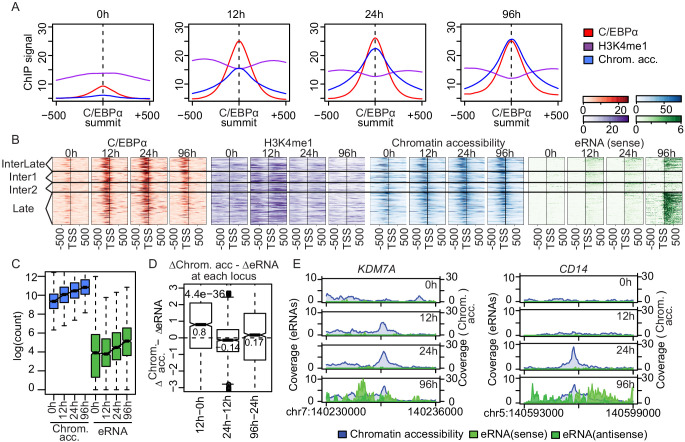
Enhancer transcription follows chromatin opening.(A) Average signal of ChIP-seq of C/EBPα (red) and H3K4me1 (purple) or ATAC-seq (blue) on C/EBPα binding sites where chromatin accessibility is limited at 0 hr (n = 4550). Each panel depicts coverage at the indicated time. (B) Coverage plots of genome-wide data sets as indicated. Rows of all panels represent enhancers occupied by C/EBPα, sorted by eRNA synthesis kinetics and intensity. The coverage was aligned to the transcription start site (TSS) of eRNAs. (C) Log2-transformed counts of chromatin accessibility and eRNA synthesis on enhancers within chromatin regions previously inaccessible at 0 hr. (D) Difference between changes of chromatin accessibility and changes in eRNA synthesis at each locus (y-axis) between indicated time points (x-axis). Log2-transformed counts of chromatin accessibility and eRNA synthesis on enhancers within chromatin regions previously inaccessible at 0 hr. (E) Coverage tracks of eRNA synthesis (green) and chromatin accessibility (blue) over indicated time points illustrate that chromatin becomes accessible before enhancer transcription at KDM7A and CD14 enhancers.